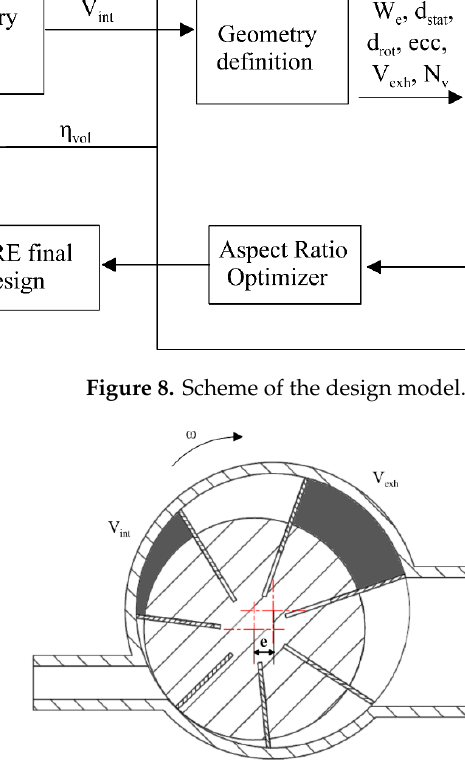
Figure 9. Intake (left) and exhaust (right) volume .